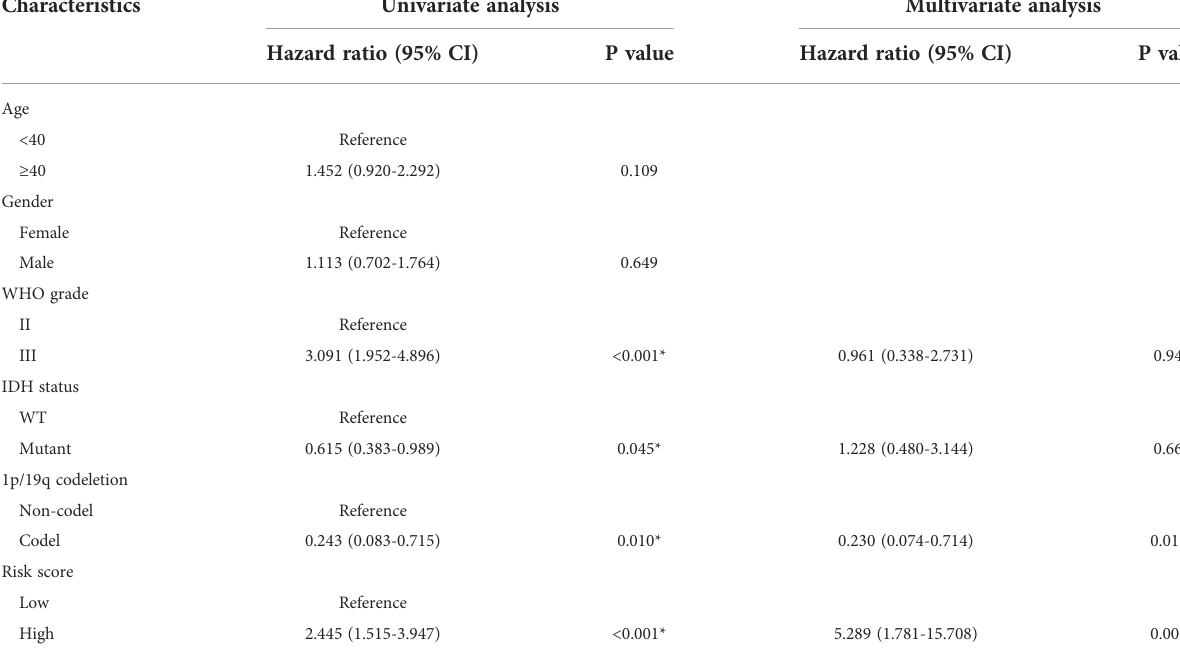
TABLE 3 Univariate and multivariate Cox regression analyses in CGGA microarray dataset.